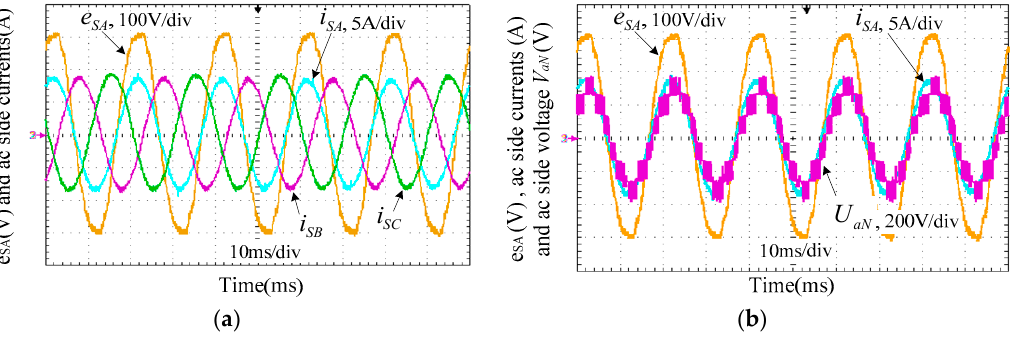
Figure 9. Voltages and currents of the drive converter in the steady ‐ state. ( a ) Input voltage and currents; ( b ) Input voltage and current, and AC terminal phase voltage of phase A. ( b ) Input voltage and current, and AC terminal phase voltage of phase